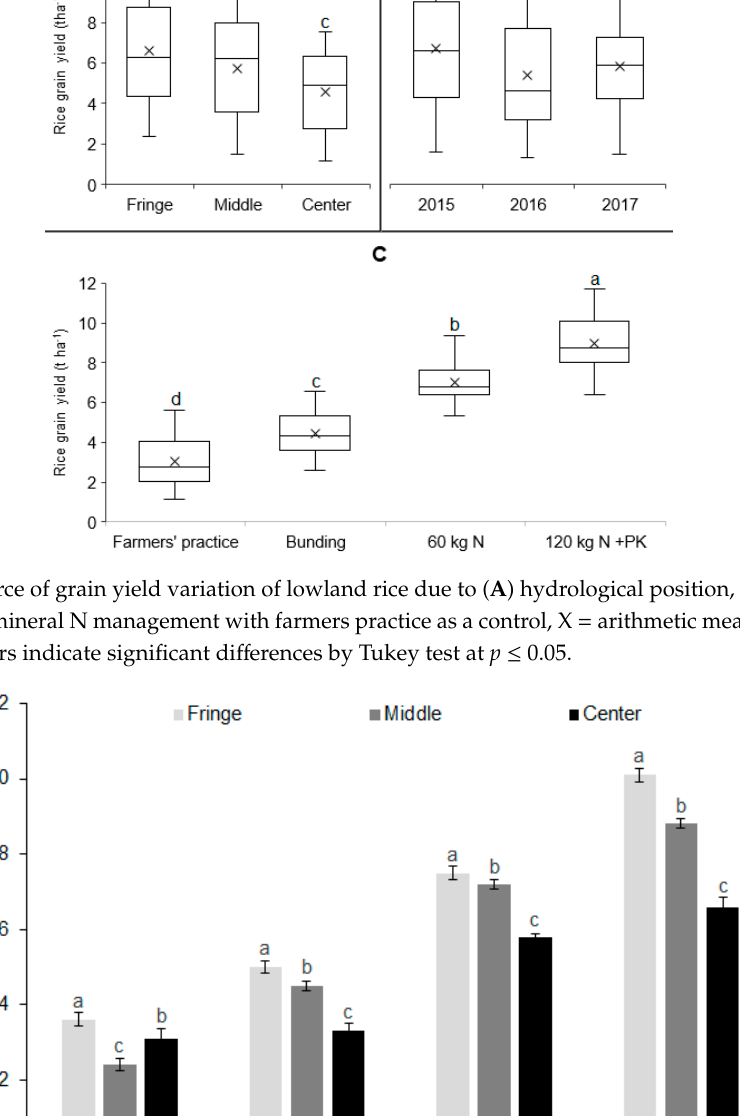
Figure 5. Nitrogen uptake by rice grain and straw across years (2015–2017) as affected by management practices. Different letters indicate significant differences by Tukey test at p ≤ 0.05 between positions. * “Attainable yield” treatments comprised of supplementary application of P and K .